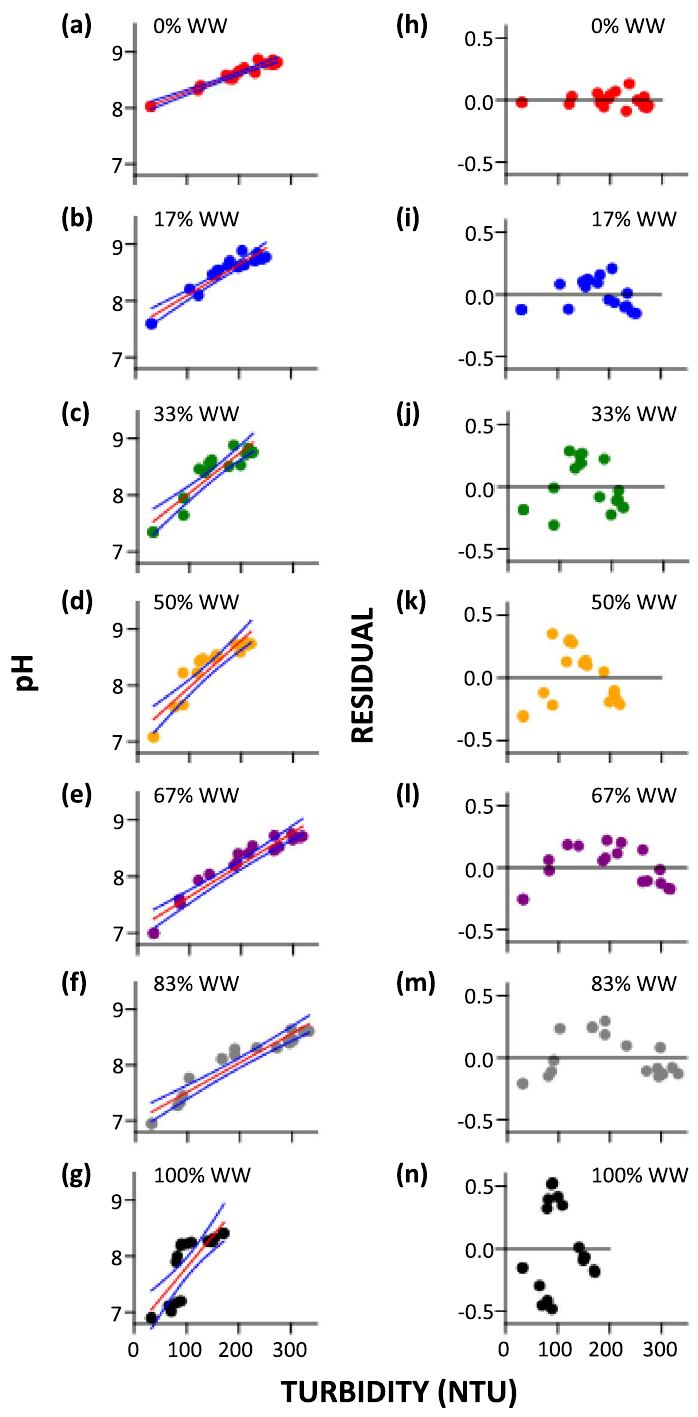
Figure 1. Scatter plots of pH changes as a function of turbidity ( a )–( g ) and associated residual plots ( h )–( n ) under different WW/DH 2 O ratios. pH and Residual pairs ( a ) and ( h ) are for the 0%WW/100%DH 2 O ratio, ( b ) and ( i ) pair: 17%/83%, ( c ) and ( j ): 33%/67%, ( d ) and ( k ): 50%/50%, ( e ) and ( l ): 67%/33%, ( f ) and ( m ): 83%/17%, and ( g ) and ( n ): 100%WW/0%DH 2 O